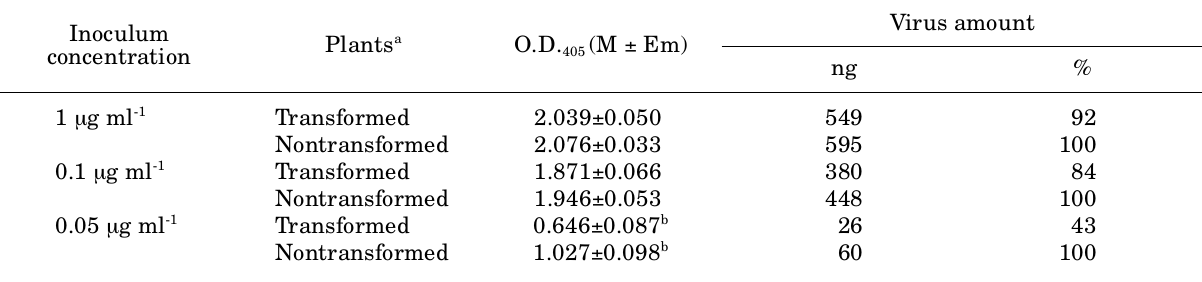
Fig. 1. PCR amplification of the 2’-5’A oligoadenylate synthetase gene from genomic DNA of transformed plants. A, agarose gel electrophoresis of PCR products: MW, DNA molecular weight marker; 1, untrasformed tobacco; 2–6, transformed tobacco plants; 7, positive con- trol (pBI121-E18). B, hybridization of the above PCR bands with the digoxigenin-labelled specific gene probe. Table 1. Virus content of tobacco plants transformed or nontransformed with 2’-5’A synthetase gene inoculated with various PVX concentrations, as determined in ELISA tests.